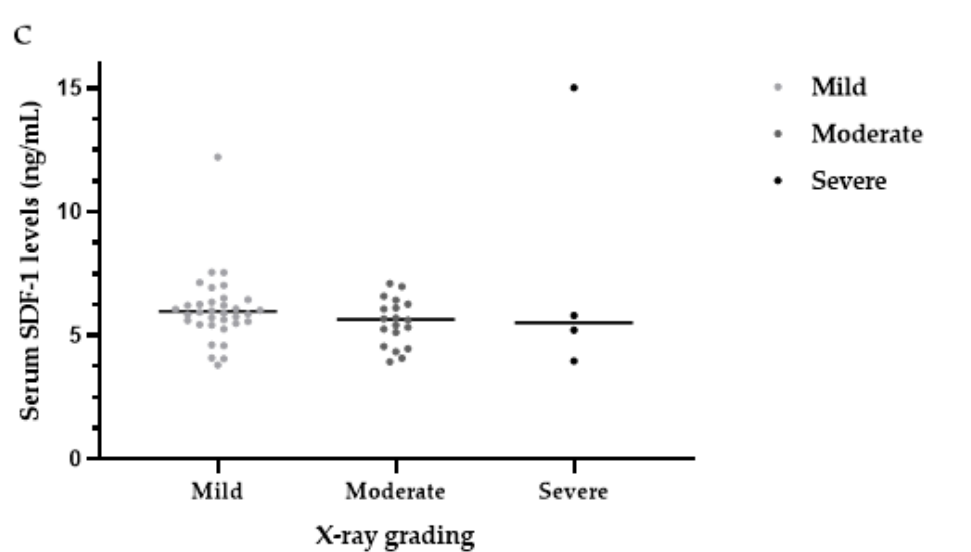
Figure 5. ( a ) Analysis of serum SDF-1 levels in the SF group and control group; ( b ) Analysis of SDF-1 levels in the SF group by sex and age; ( c ) Analysis of SDF-1 levels in the SF group by X-ray diagnostic grade. * p < 0.05 compared to the control group. SDF-1: stromal cell-derived factor-1. There were no significant differences in serum levels of SDF-1 between males (5.77